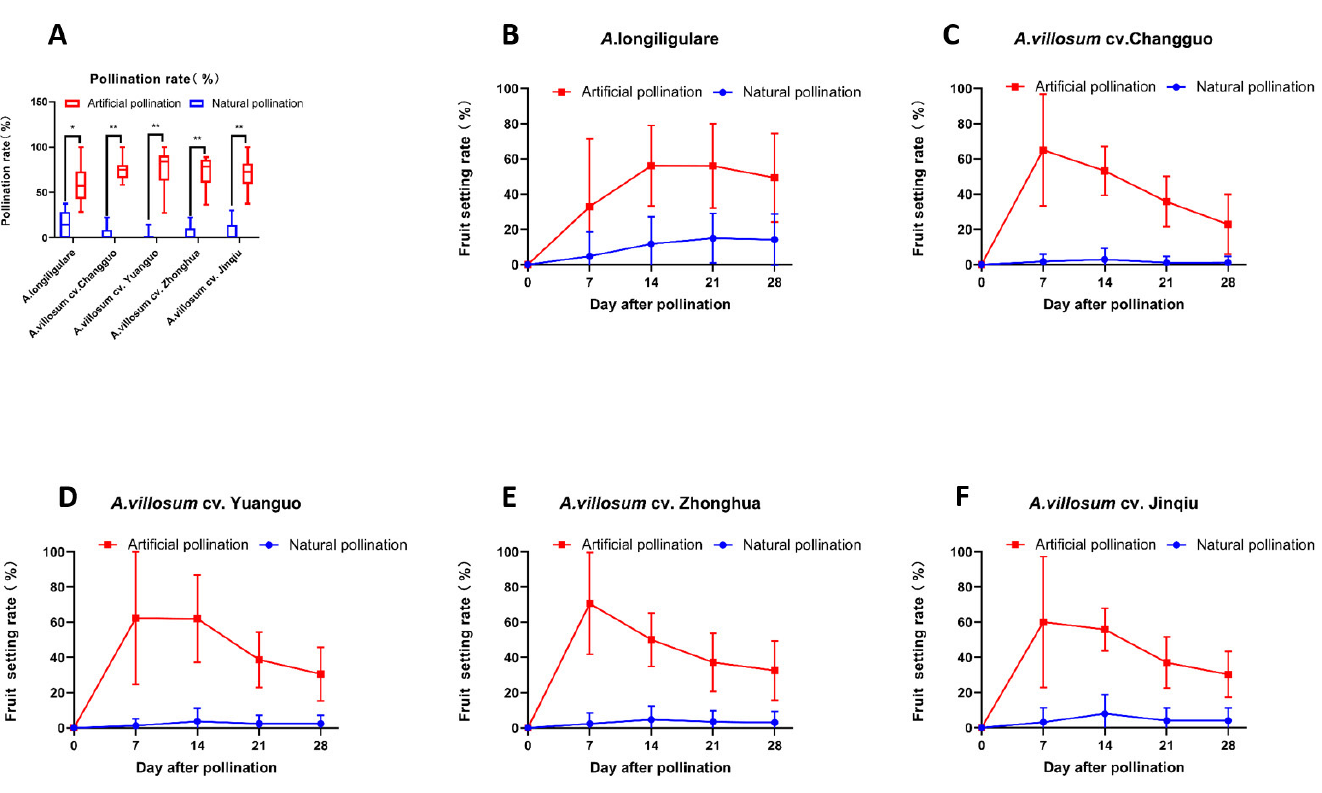
Fig 2. Effects of different pollination methods. (A) Different Pollination rate between Natural pollination and Artificial pollination, (B-F) Change with time after imposition of Pollinations in fruit setting rate of 5 Amomum germplasms between Natural pollination and Artificial pollination. n = 18 per group. Data are presented as mean ± SD. � P < 0.05, �� P <